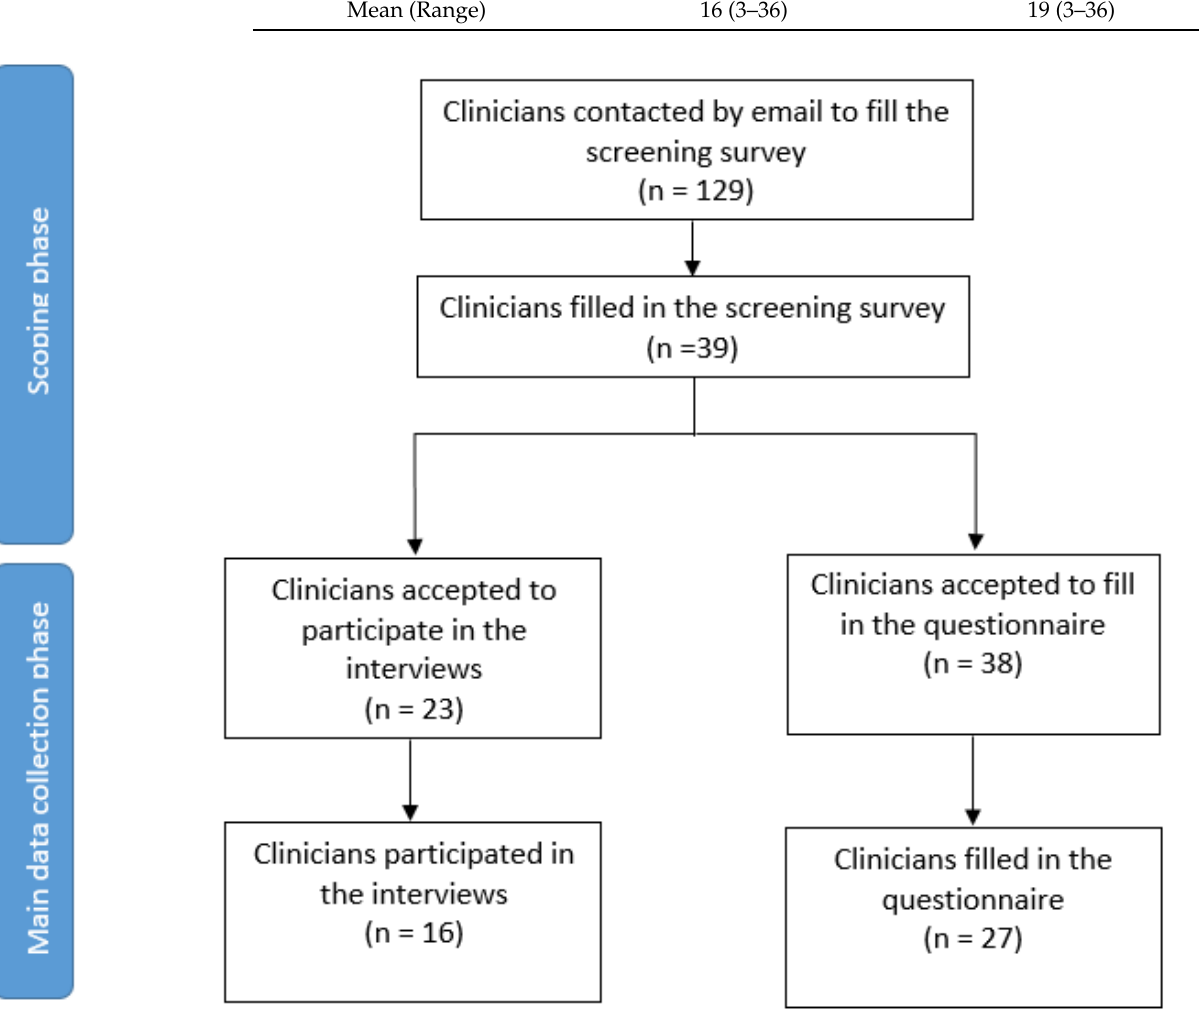
Figure 3. Flow diagram of the respondents.